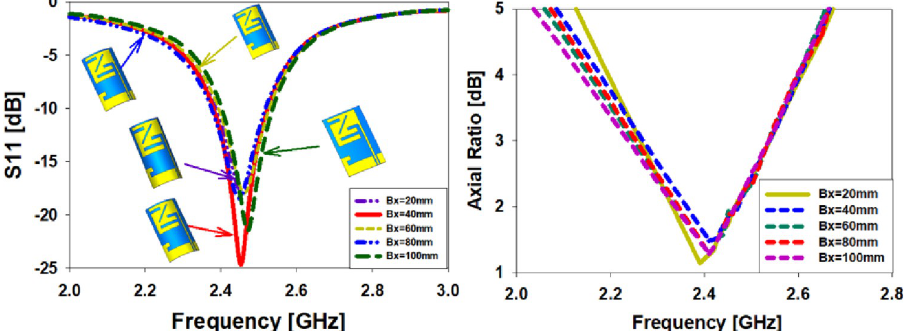
Fig 9. Antenna bending analysis at 2.45 GHz, (a) difference in S 11 , (b) comparison in AR.